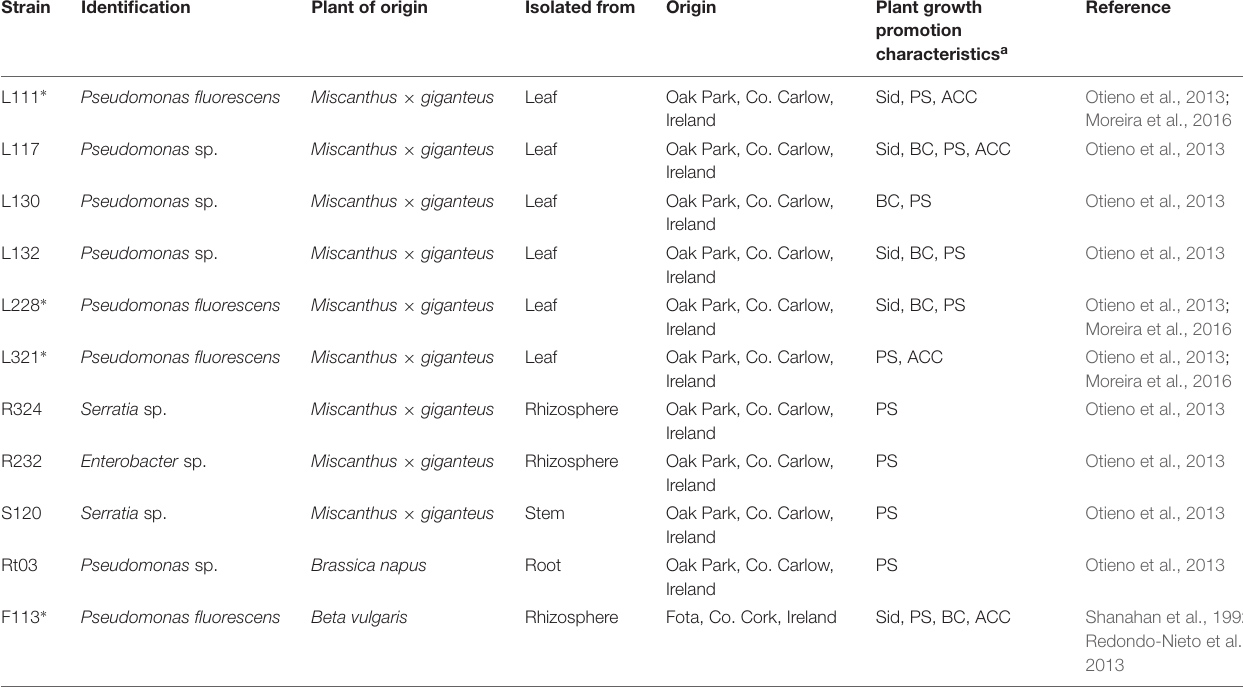
TABLE 1 | List of strains used in this study; origin and plant growth promoting